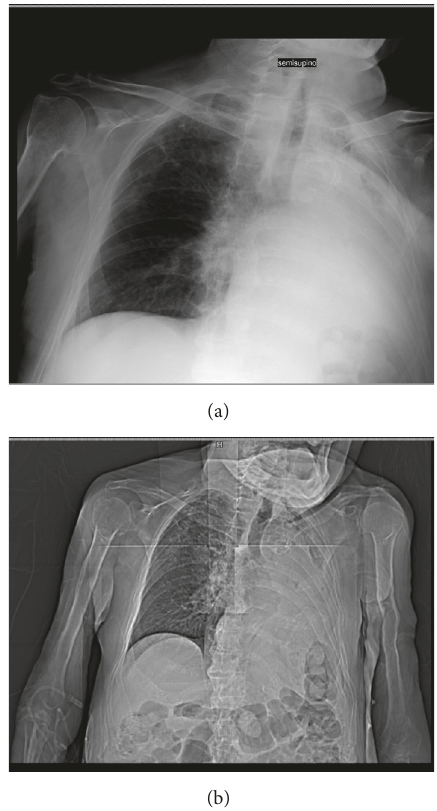
Figure 1: Complete left pulmonary opacification.